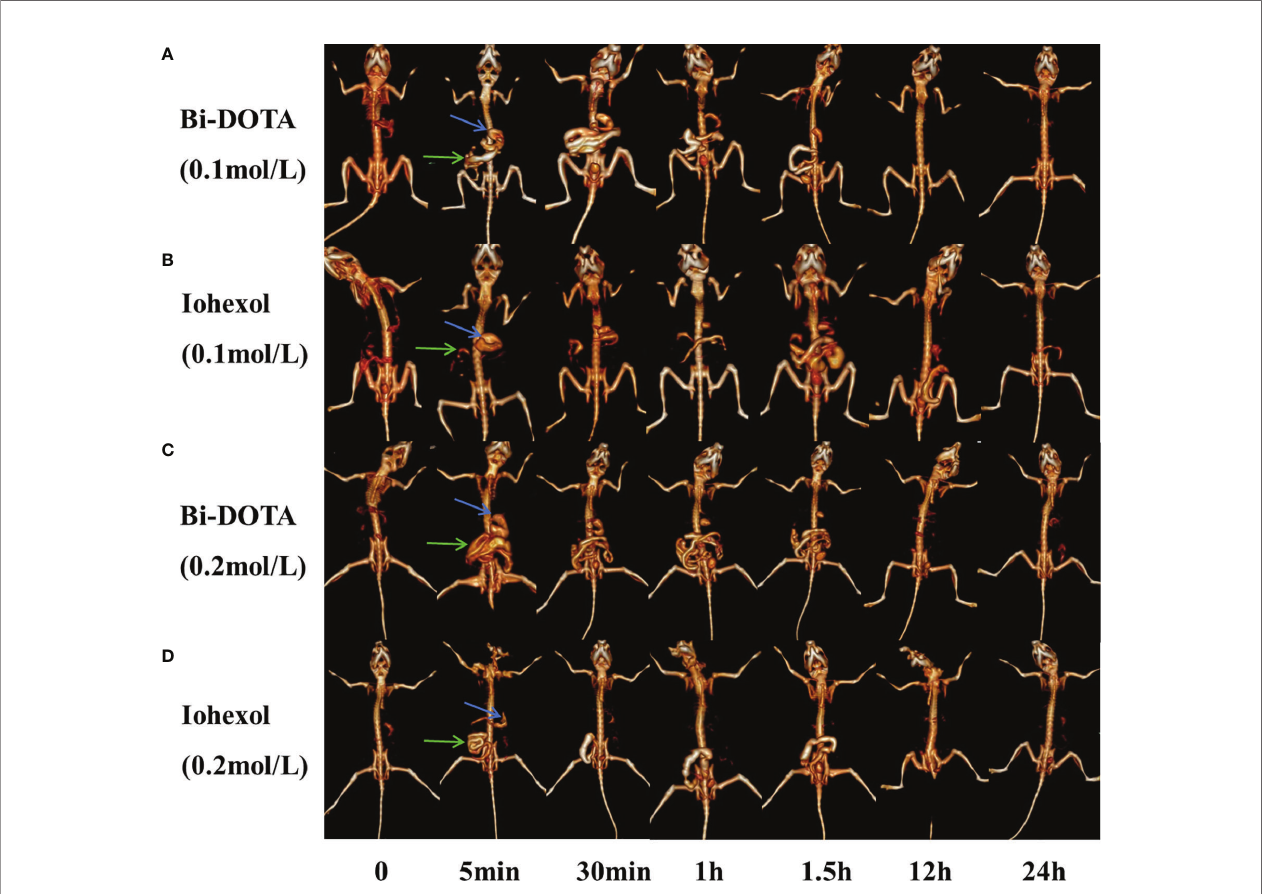
FIGURE 6 | In vivo GI tract CT imaging after oral administration of (A) 0.1 mol/L Bi-DOTA, (B) 0.1 mol/L iohexol, (C) 0.2 mol/L Bi-DOTA, and (D) 0.2 mol/L iohexol (blue arrows represent stomach and green arrows represent small